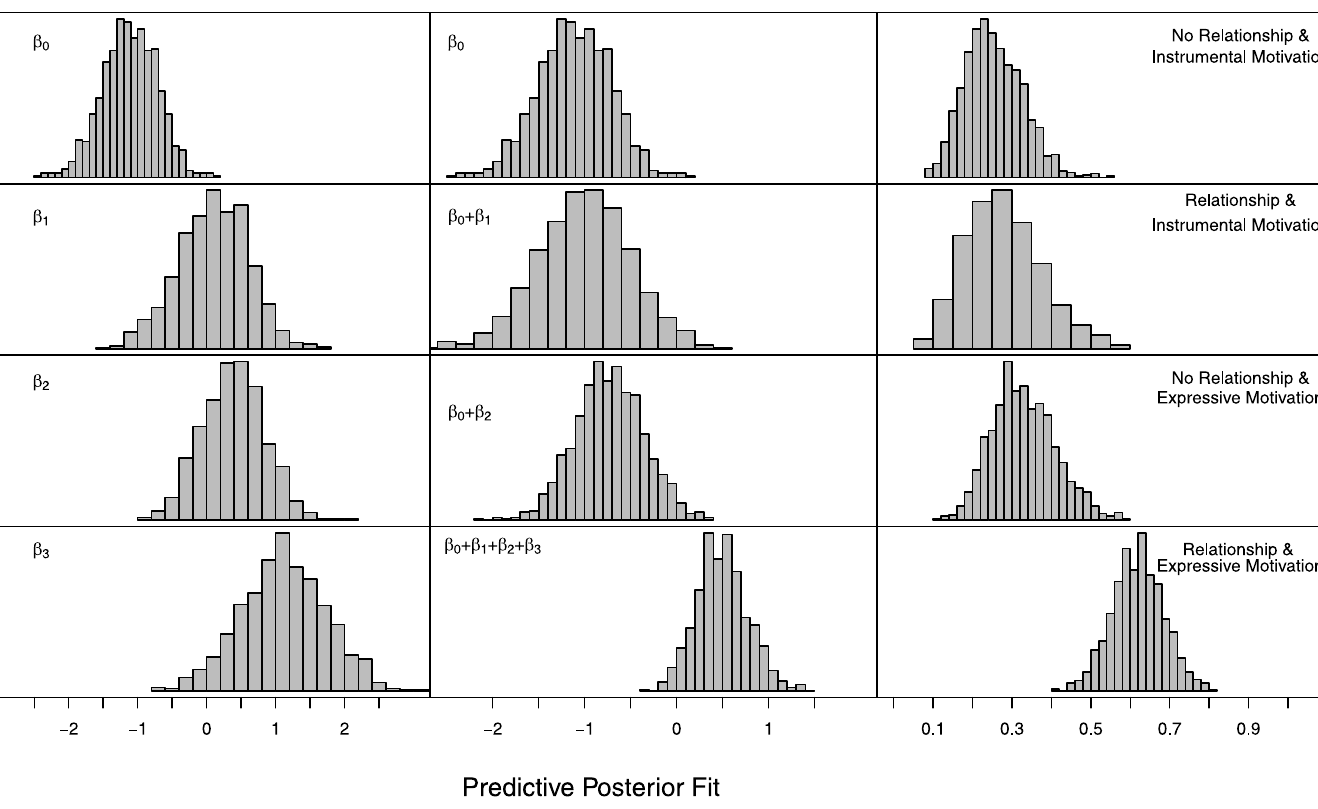
Fig 4. Posterior distributions of coefficients (left column), linear predictors (middle column) and predictive fits (right